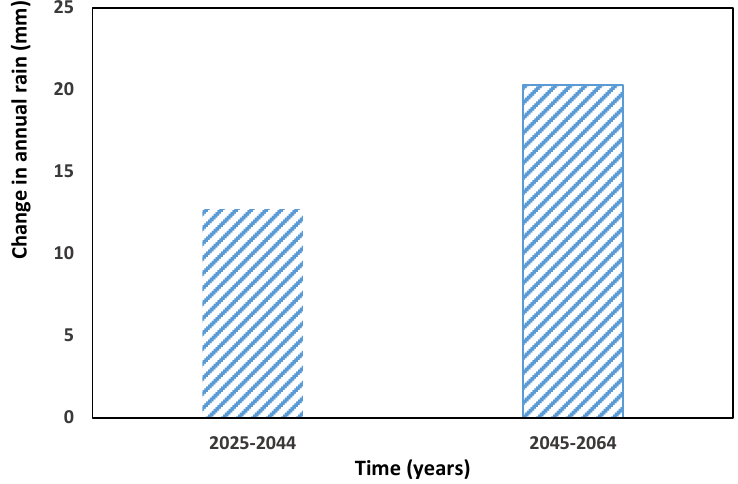
Figure 1. Predicted change in precipitation in Qassim